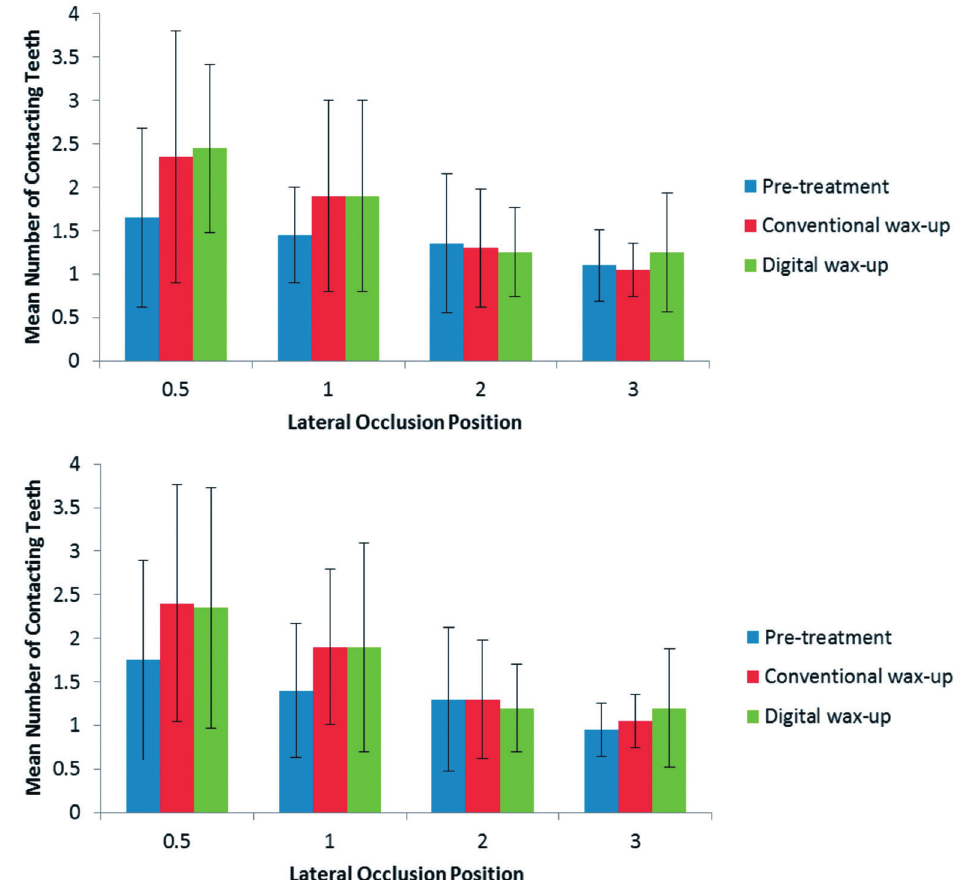
Figure 5- The mean number of contacting teeth for all the models in each excursive position. (A) Maxillary arch; (B) Mandibular